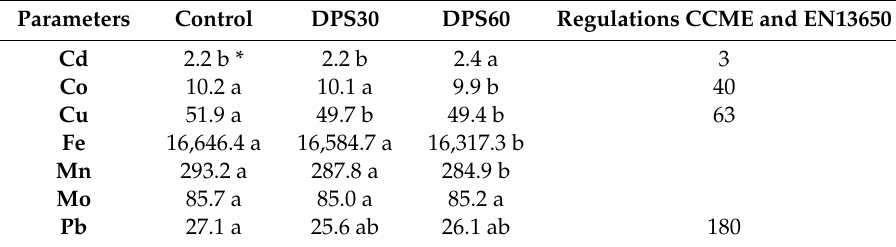
Table 6. Trace element concentrations (mg / kg) after two annual DPS applications. Treatments: